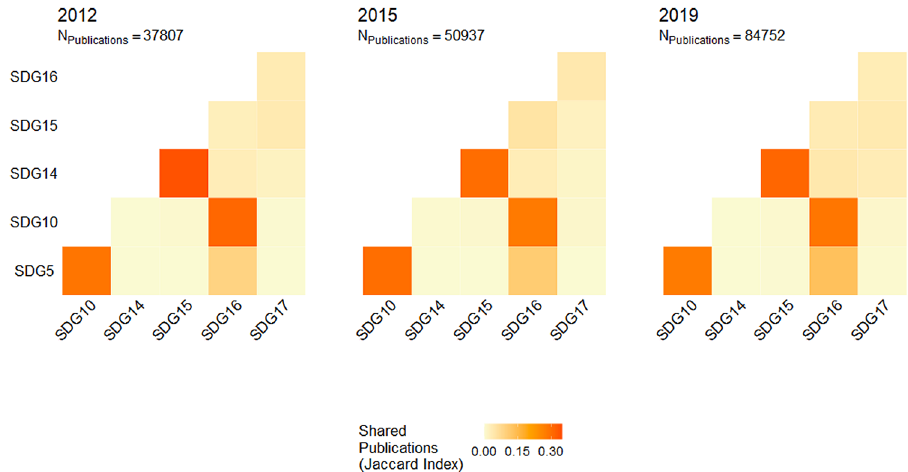
Figure 2. Overlap (Jaccard Index) between scientific articles classified as relevant to SDGs 5-Gender, 10-Inequality, 14-Aquatic, 15-Terrestrial, 16-Peace, and 17-Partnerships since 2012 (the year SDGs were first proposed at the Rio + 20